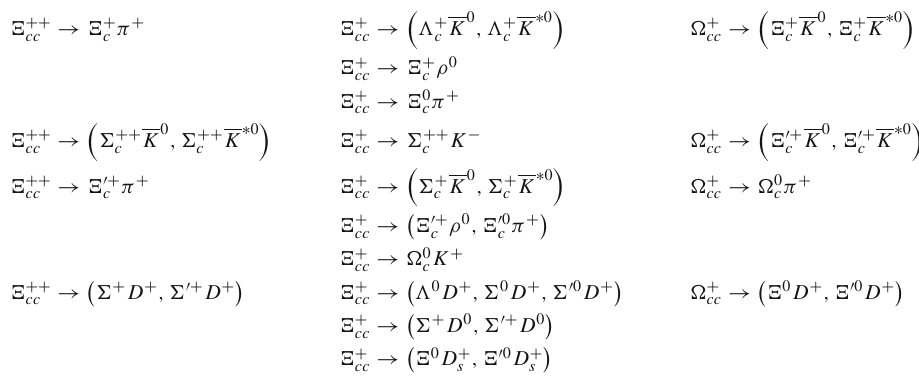
Fig. 1 Feynmandiagramsfortwo-bodydecaysofdoublycharmedbaryons.Weonlyshowonetypeofpenguindiagrams.The C , C (cid:4) , B , E diagrams are suppressed by 1 / N c Table 1 Cabibbo allowed